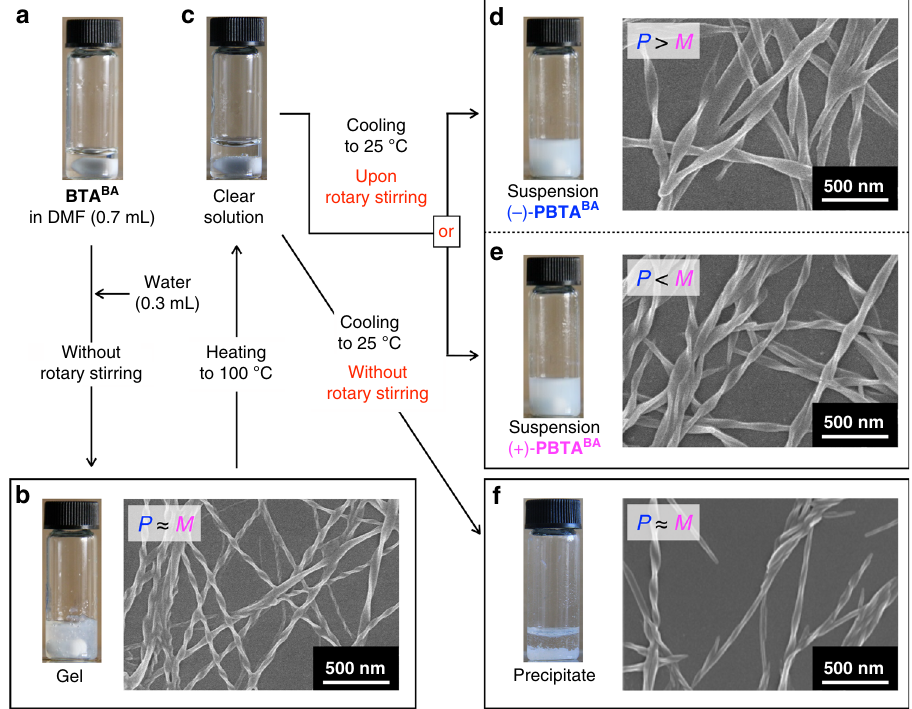
Fig. 2 Procedures for the preparation of mirror symmetry-broken helical PBTA BA nanoribbons. a Photograph of a DMF (0.7 mL) solution of BTA BA (3